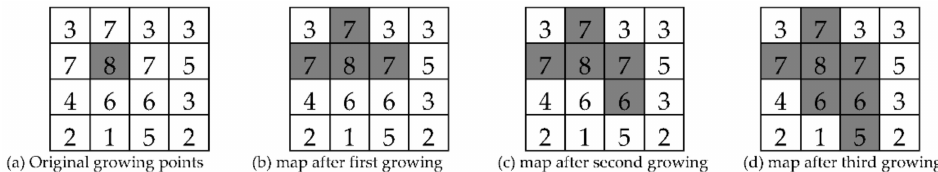
Figure 3. Illustration of regional growth: ( a – d ) represent the four steps of the regional growing algorithm, respectively.